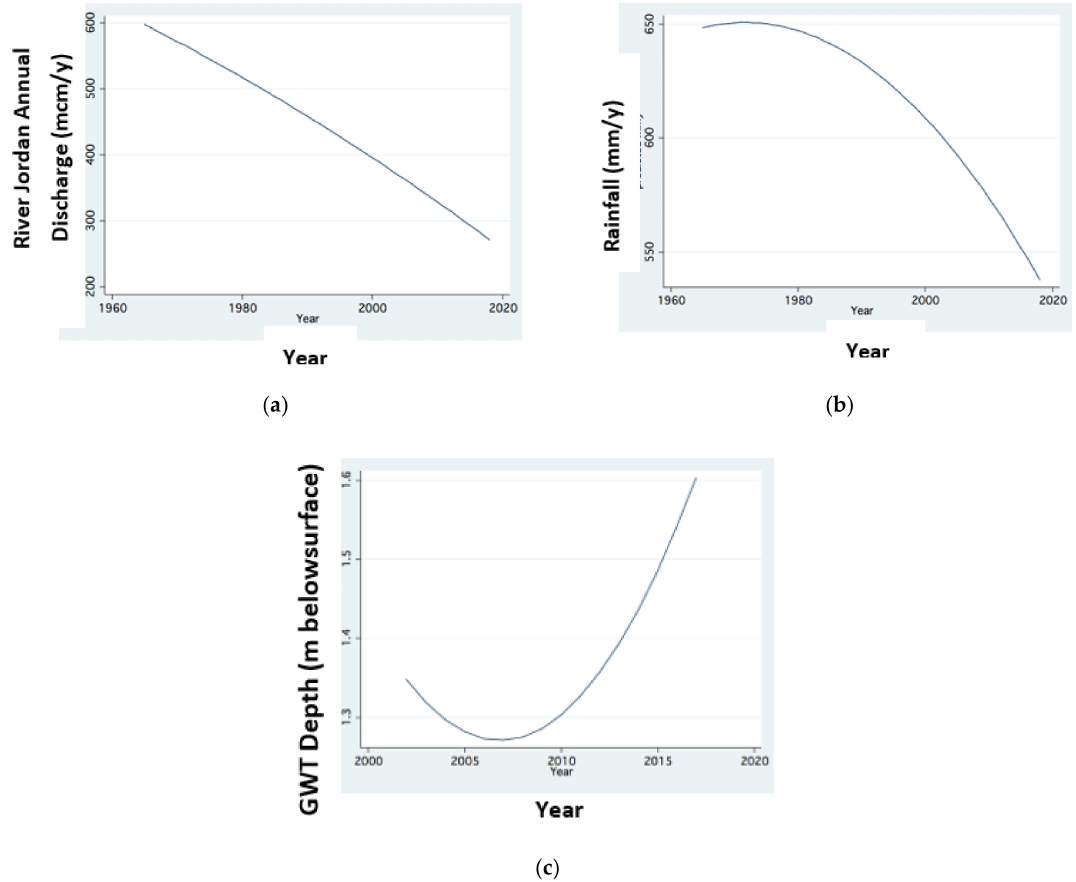
Figure 2. Climate change in the Lake Kinneret drainage basin: decline in the River Jordan annual discharge (106 m 3 /year) during 1960–2020 ( a ), decline in annual precipitation (mm/year) ( b ), and lowering of the GWT depth (annual total Hula Valley average during 2003–2020) ( c ).